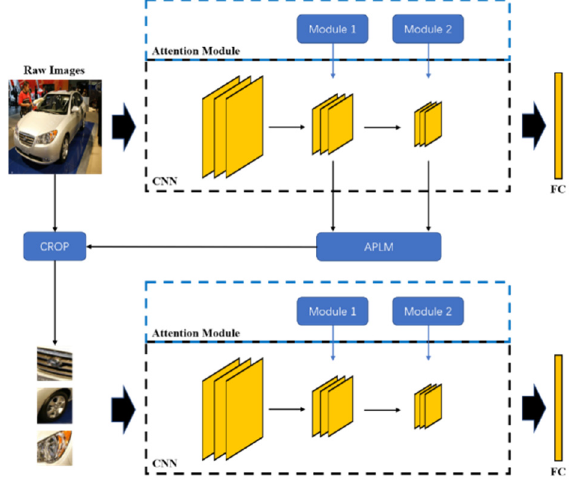
Figure 1. The framework of TBAL-Net. Both channel and spatial attention modules, namely, module 1 and module 2 in the figure, are added to the CNN backbone for feature extraction. The extracted feature maps are fed into the APLM, where critical regions are highlighted and used to guide the cropping module, which crops a number of top-informative regions from the raw image. Finally, the generated part images are fed into the CNN backbone for further feature extraction, aiming to learn more visual patterns from the part images to enhance feature representation for FGVC. The extracted feature map passes a fully connected (FC) layer followed by the detection head.